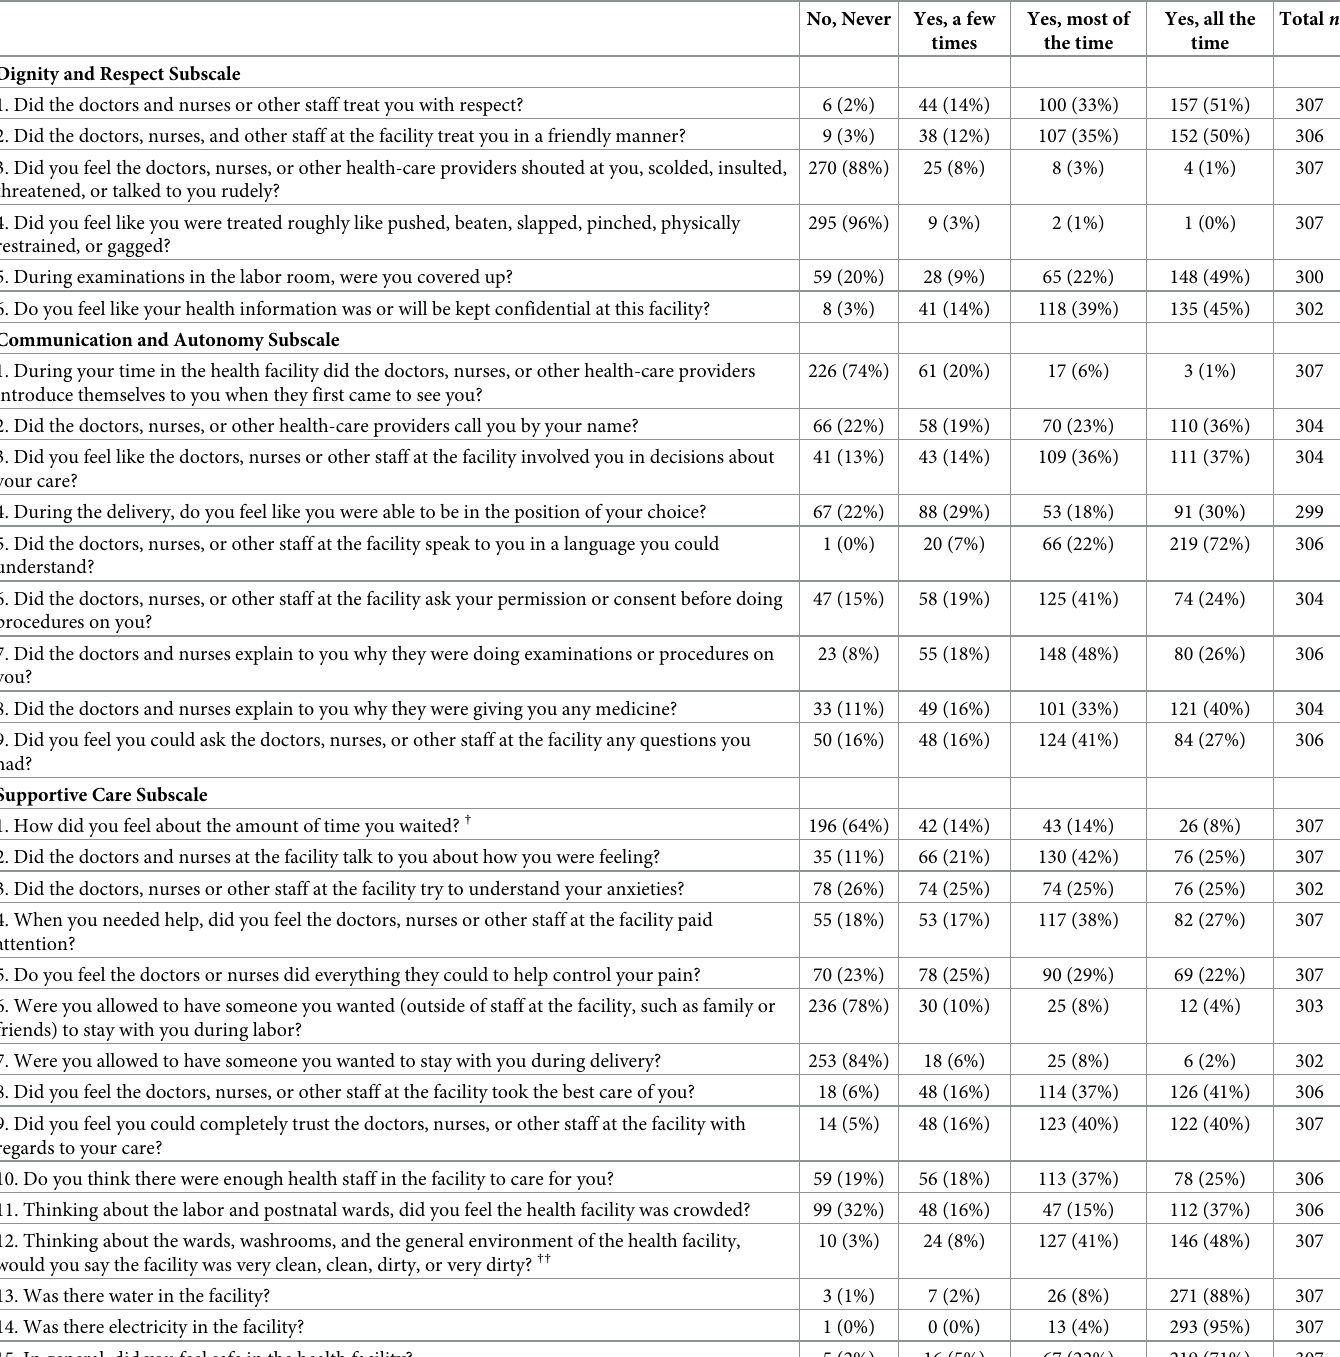
No, Never Yes, a few Yes, most of Yes, all the Total n times the time time